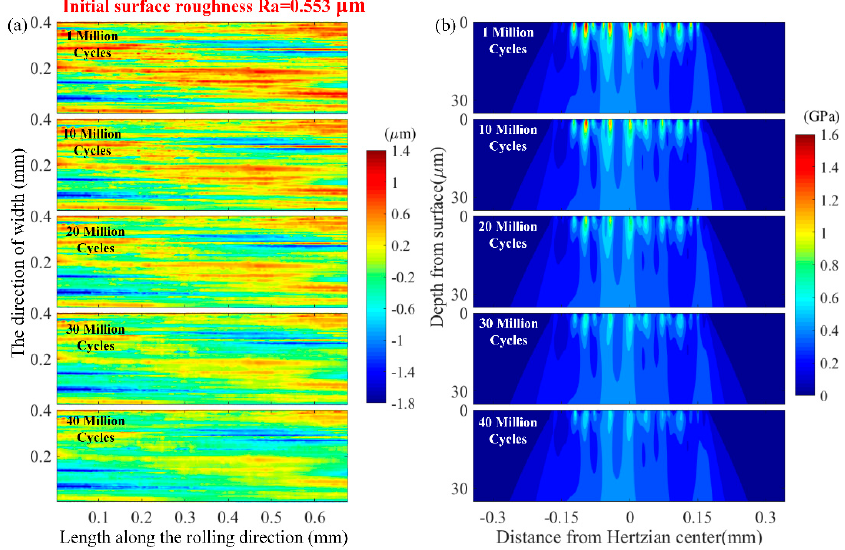
Figure 20. ( a ) The evolution of surface roughness and ( b ) the evolution of octahedral shear stress from 1 million to 40 million cycles [121].